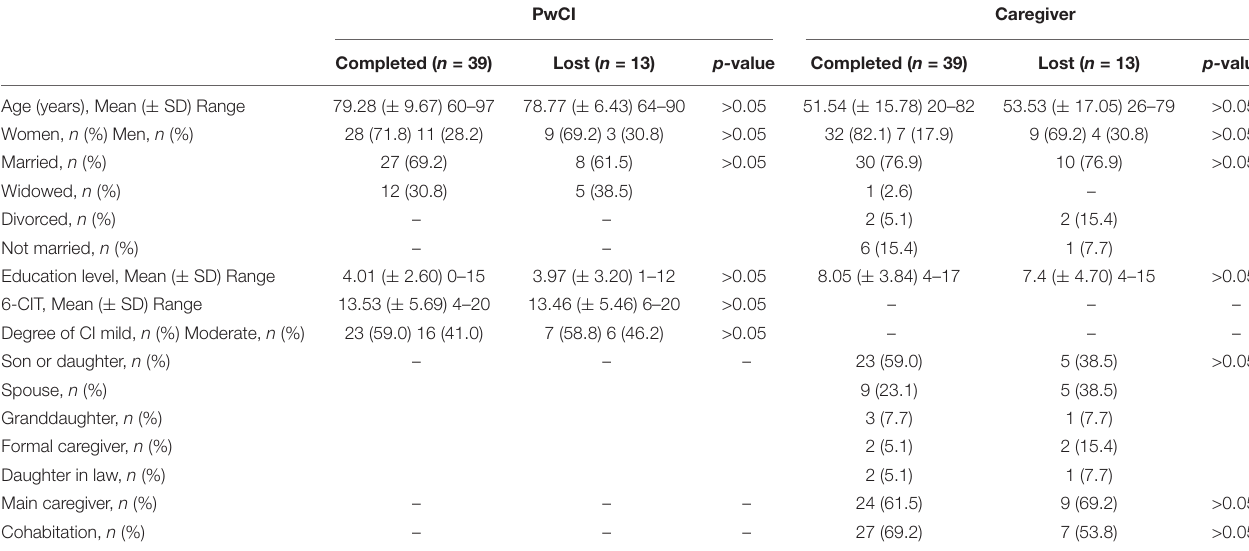
TABLE 1 | Sociodemographic characteristics of PwCI and caregiver by lost and completed.